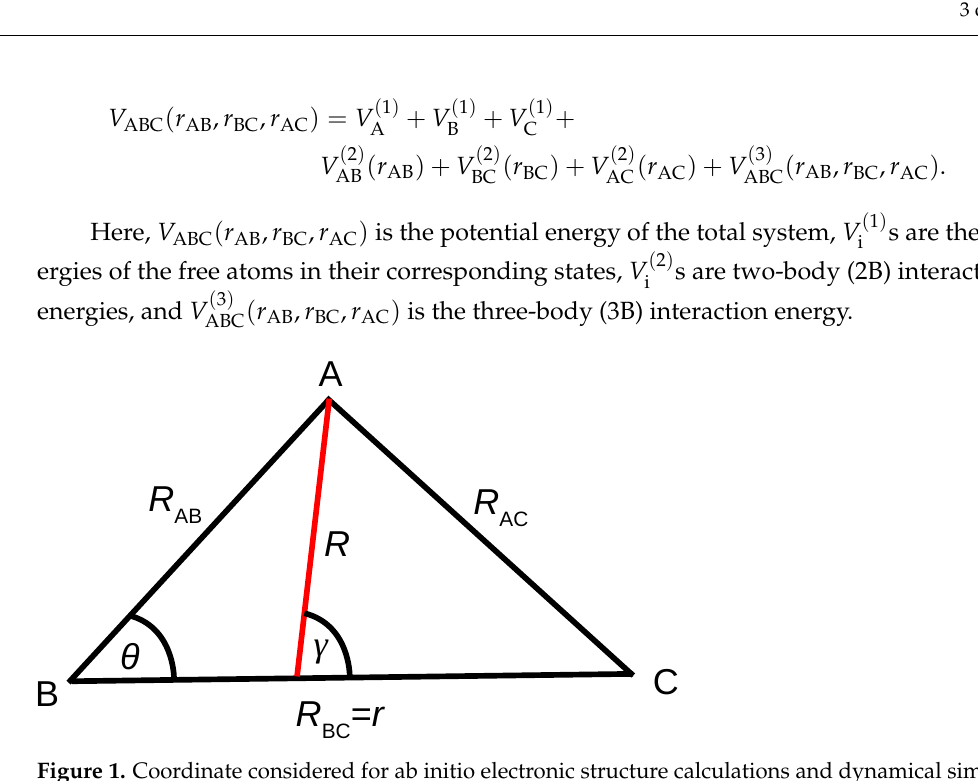
Figure 1. Coordinate considered for ab initio electronic structure calculations and dynamical simula- tions. r AB , r BC , and r AC are the distances between atoms A and B, B and C, and A and C, respectively. θ is the angle between r AB and r BC . While the set r AB , r BC and θ is used for the ab initio points, the Jacobi coordinates set of R , r and γ is used for the propagation, where R is the distance from the center-of-mass of BC to A and γ is the angle between R and r